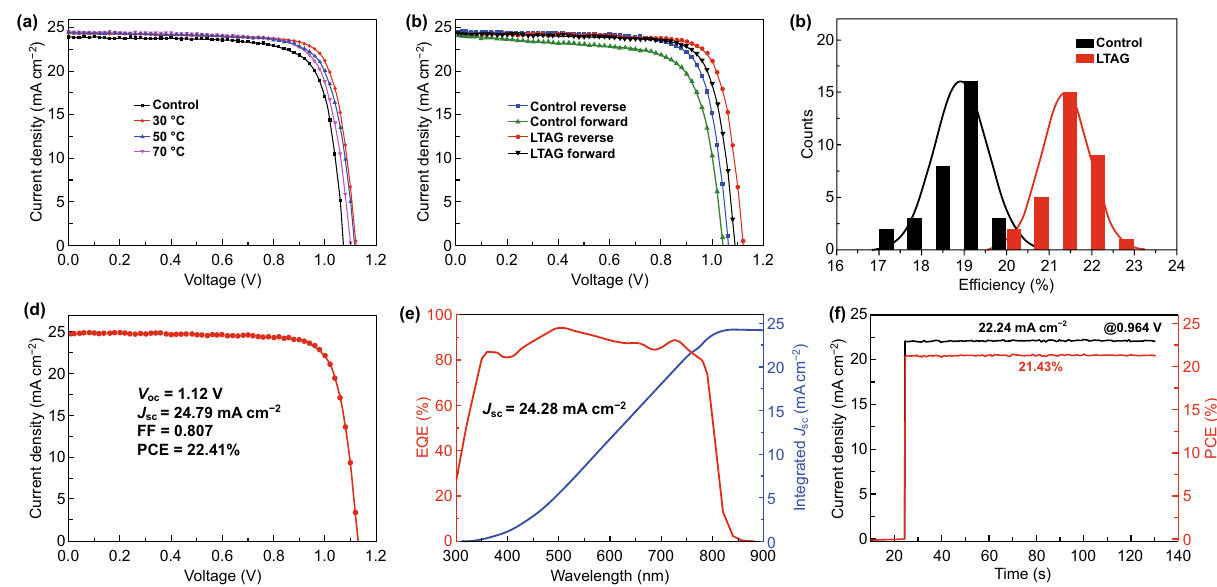
Fig. 3 a J – V curves of devices prepared using the LTAG method (at 30, 50, and 70 °C), compared with that of the control device. b J – V curves recorded from reverse and forward scans for the control device and the LTAG‑30 solar cell. c Distributions of PCEs measured from the control and LTAG‑30 devices. d J – V curve of the best‑performing LTAG‑30 perovskite solar cell. e EQE spectrum and integrated value of J sc of the best‑performing LTAG‑30 device. f Stabilized current density and power output of the best‑performing LTAG‑30 device, measured close to the maximum power point